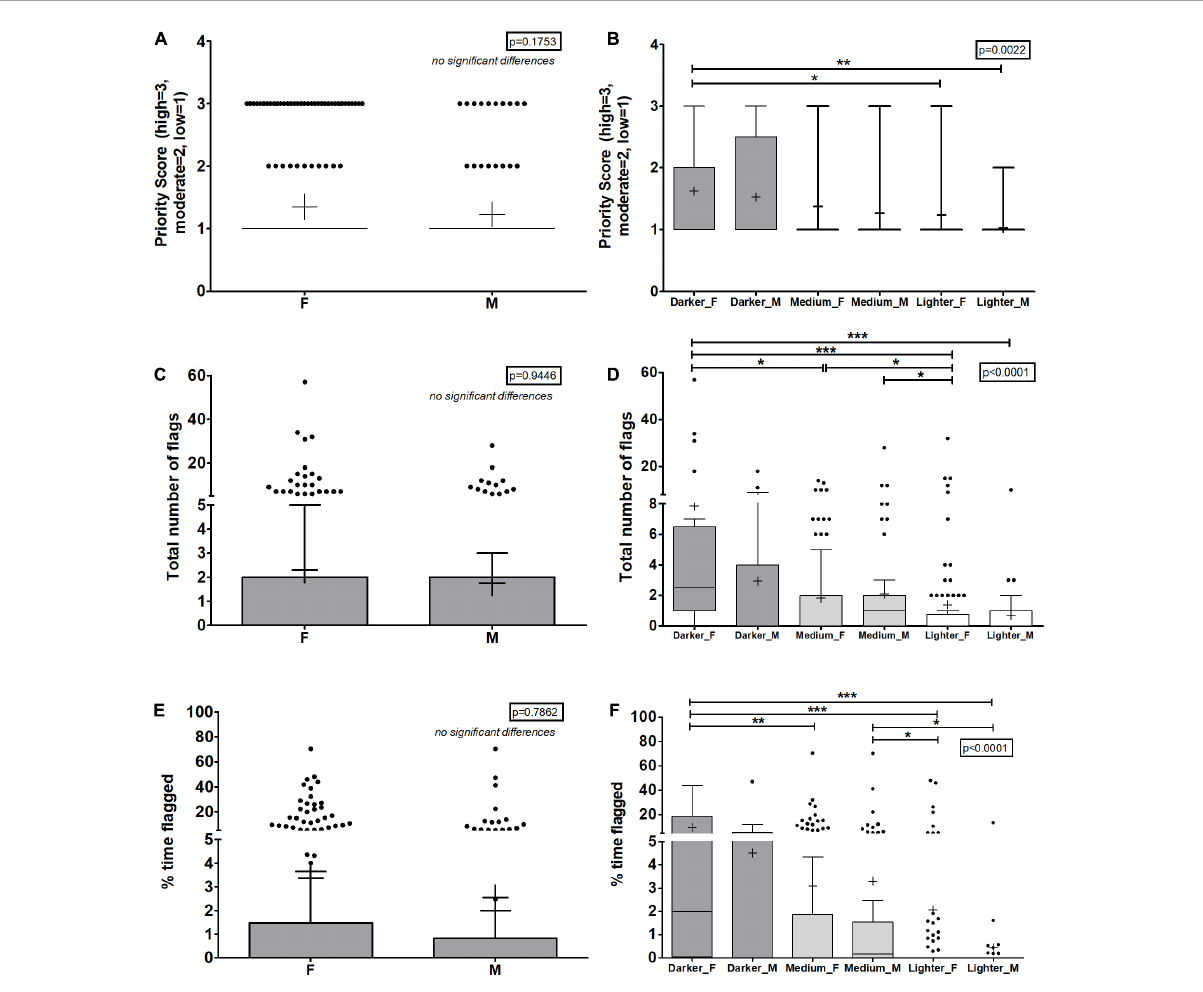
FIGURE4 Overall metrics by the automated test proctoring software based on sex and intersectional data of sex and skin tone. (A,B) Priority scores based on sex or skin tone classification and sex are shown with priority scores of 1, 2, and 3 indicating low, medium, and high priority for review. (C,D) The total number of flags given to a student during the assessment. (E,F) The percent of the assessment students spent being flagged by the AI algorithm. (A,C,E) Show the data based on the self-reported sex of the students. (B,D,F) Show the data based on student’s self-reported sex and skin tone classification. F, female; M, male. Box plots represent 25 and 75% confidence intervals with whiskers represent Tukey’s distributions and dots represent data outliers. Lines inside the boxes represent the median values and + indicate the mean values. Note the divided y -axis scales on some plots to accommodate the wide range of values. Kruskal Wallis non-parametric tests yielded an overall p -values indicated on each plot and Dunn’s post-test pairwise comparisons shown with brackets (* p > 0.05, ** p < 0.01, *** p <